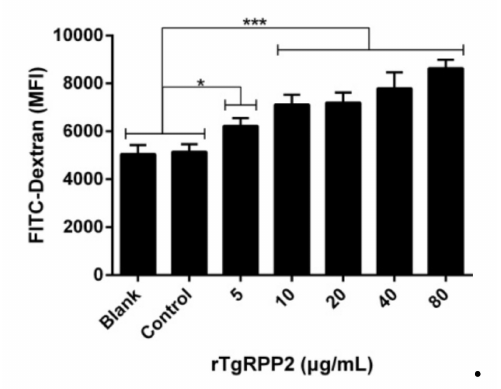
Figure 5. Recombinant TgRPP2 significantly affects the phagocytosis of murine macrophages. Me- dian fluorescence intensity (MFI) was established based on the statistical data. Values were evaluated using one-way ANOVA analysis, followed by Dunnett’s test, and presented as the mean ± standard deviation of three independent experiments ( n = 3). * p < 0.05 and *** p < 0.001 compared with the blank group or the control